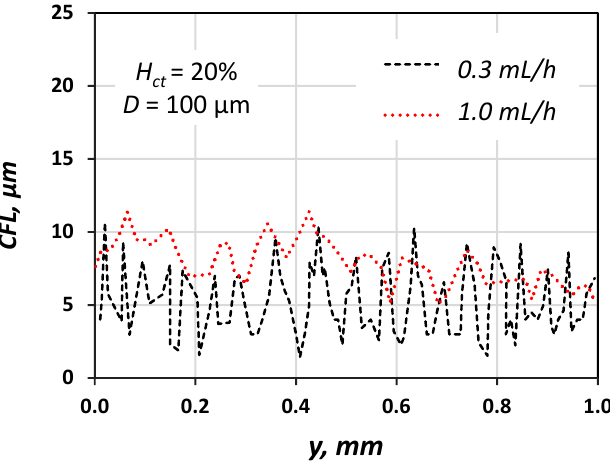
Fluids 2019 , 4 , x FOR PEER REVIEW Figure 9. Typical CFL traces for Q = 0.3 and 1.0 mL/h; H c t = 20%, D = 100 μ m (wall y = 0 μ m). Figure 9. Typical CFL traces for Q